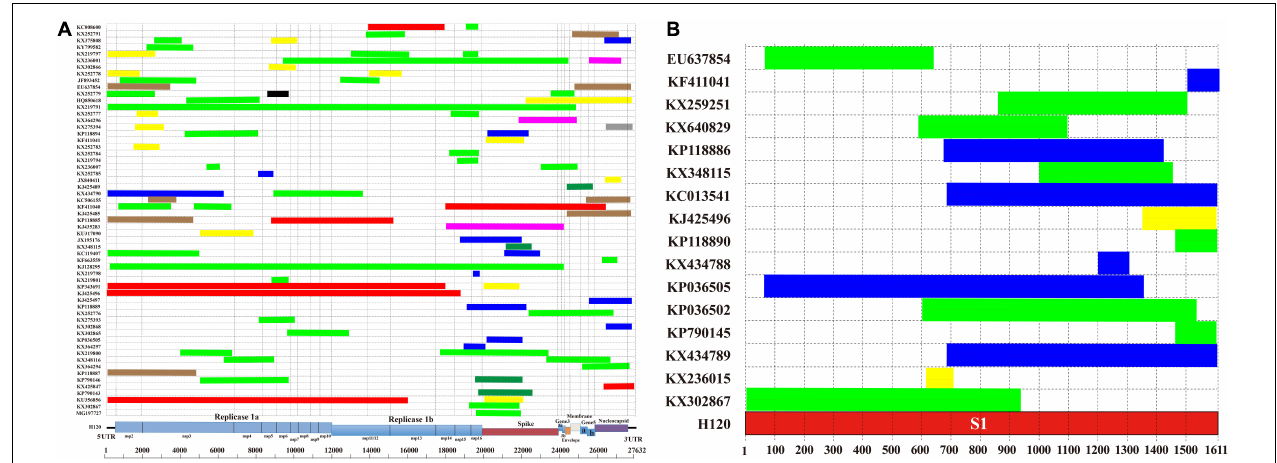
FIGURE 2 | The vaccine strain H120 was used as the reference strain. (A) The virus genome of the coronavirus avian infectious bronchitis showing the locations of 5 (cid:48) and 3 (cid:48) UTRs and the coding regions. (B) Recombination regions identified across S1 gene. Recombinant regions detected by RDP4 are highlighted in the line. The green, yellow, blue, red, dark brown, pink, dark green, black, and gray lines indicate the recombinant regions that belong to the genotype of LX4, CK/CH/LSC/99I, 4/91, Mass, Conn, Peafowl/GD/KQ6/2003, Taiwan-I, Lowa, and Georgia, respectively.